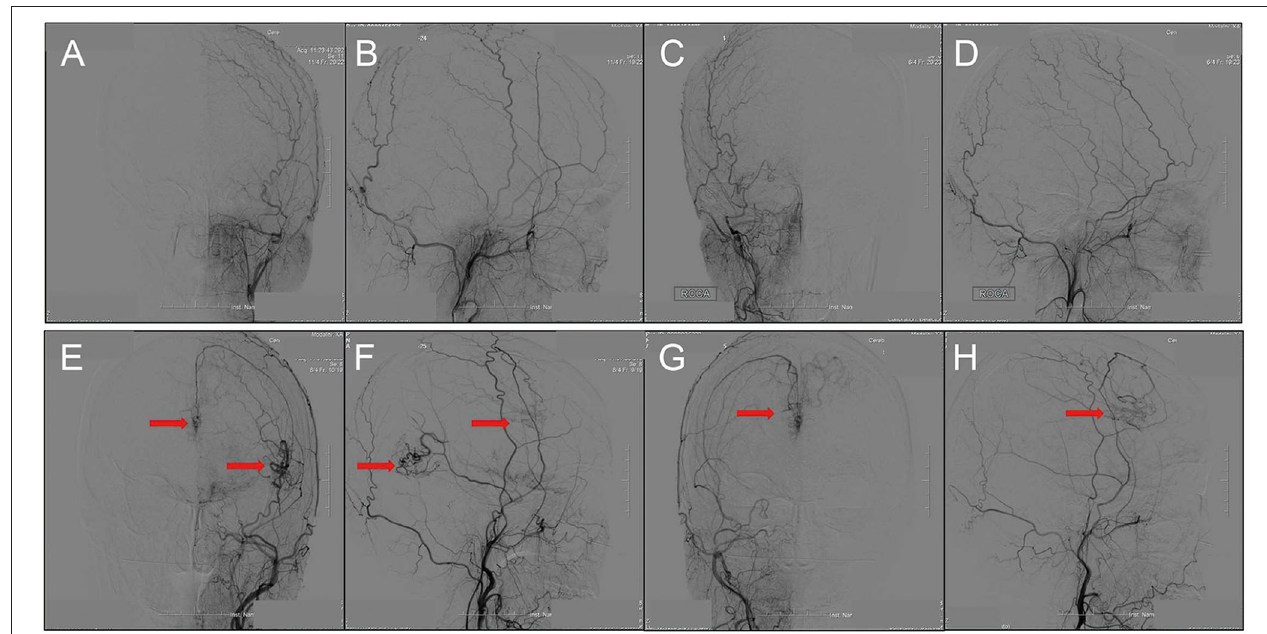
FIGURE 1 | DSA showed the transdural collaterals arising from the middle meningeal artery. (A–D) , anteroposterior (A) and lateral (B) views of left ECA injection, anteroposterior (C) and lateral (D) views of right ECA injection. There is no MMA supplying blood to the brain cortex through transdural collateral vessels. (E–H) , Anteroposterior (E) and lateral (F) views of left ECA injection, anteroposterior (G) and lateral (H) views of right ECA injection from the other patient. The MMA provides transdural collateral vessels to the brain cortex (red